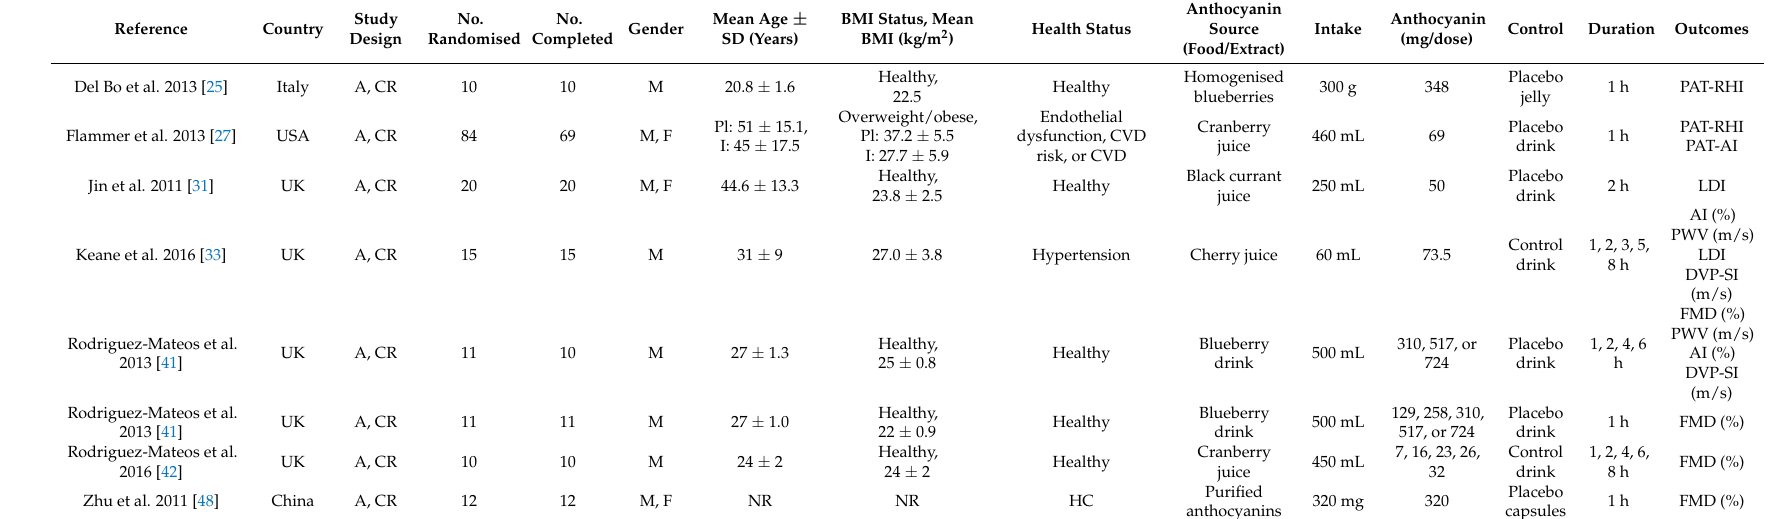
Table 2. Acute study